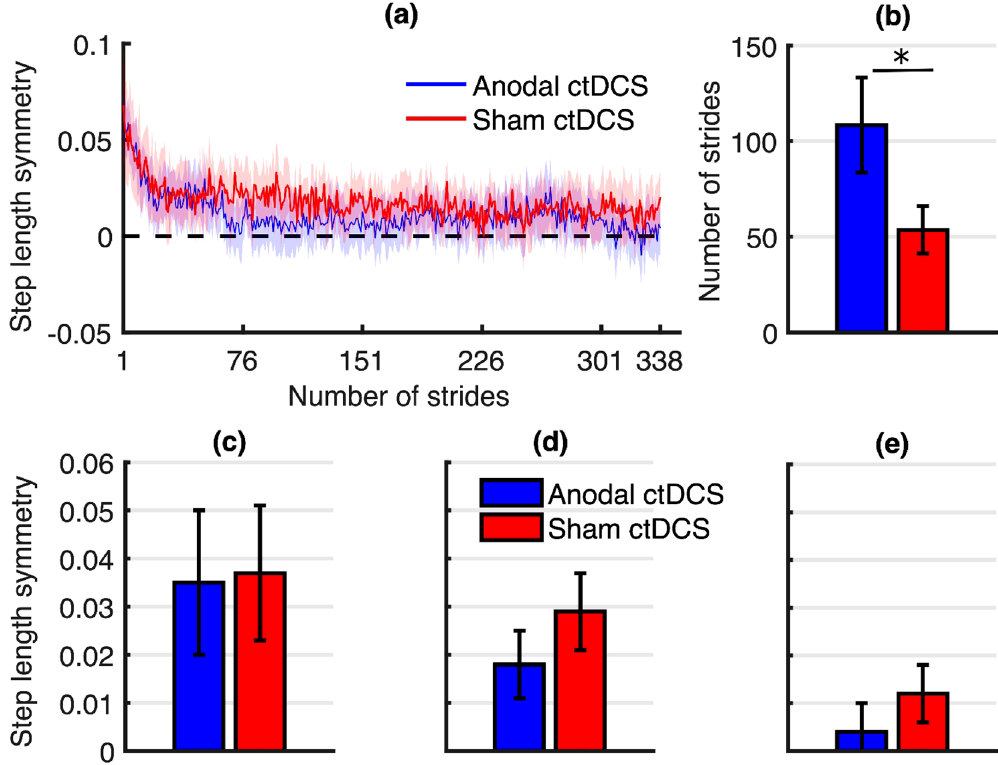
Figure 7. Graphs illustrating the results of the de-adaptation phase at the follow-up session. ( a ) Stride-by-stride mean step length symmetry plot for the anodal ctDCS group (blue) and sham ctDCS group (red) during the de-adaptation phase of the follow-up session. Lightly shaded areas indicate a 95% confidence interval. The inset bar graphs indicate mean estimates and standard error from the statistical models for ( b ) the number of strides to steady-state, ( c ) immediate de-adaptation, ( d ) early de-adaptation, ( e ) late de-adaptation.